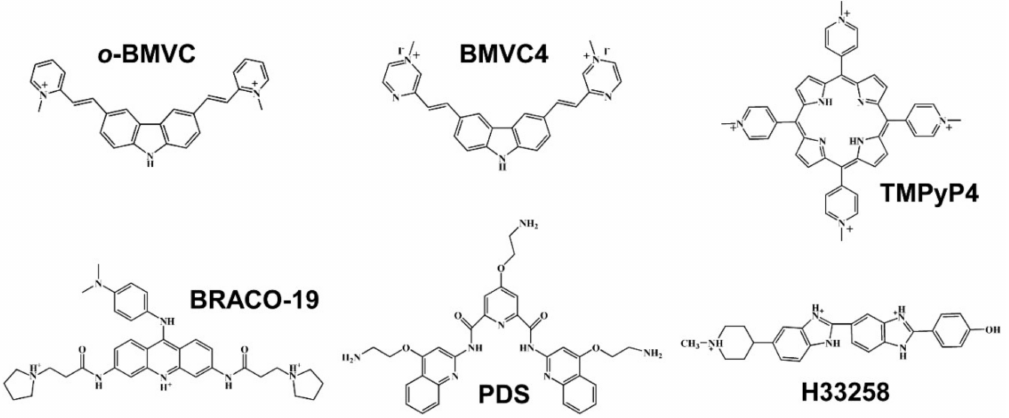
Figure 1. Chemical structure of six